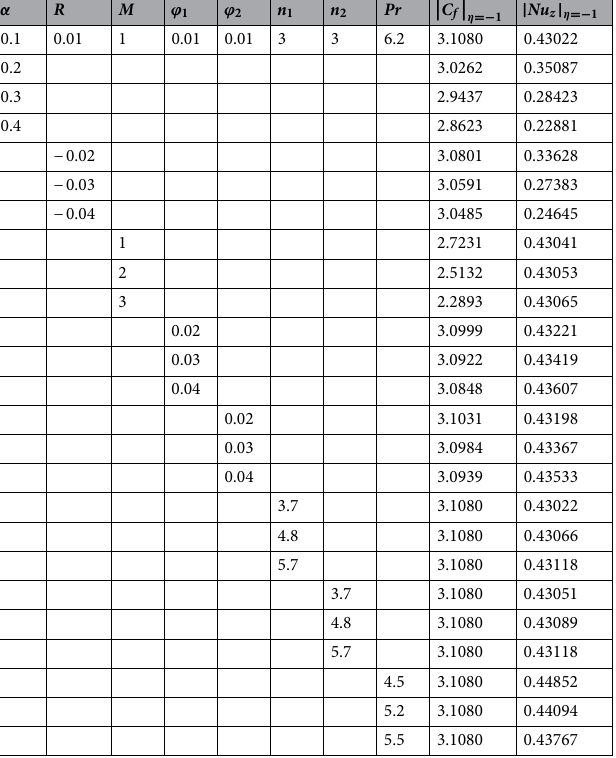
Table 8. Variation in skin friction coefficient and Nusselt number at lower wall.